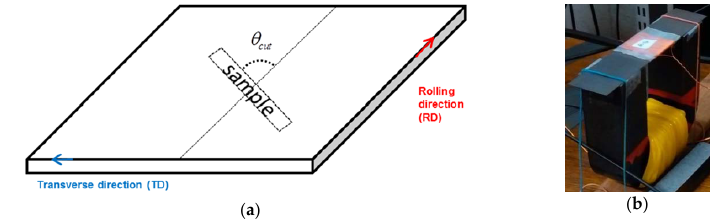
Figure 3. Single Sheet experimental procedure: ( a ) sampling; ( b ) sample’s magnetization circuit.